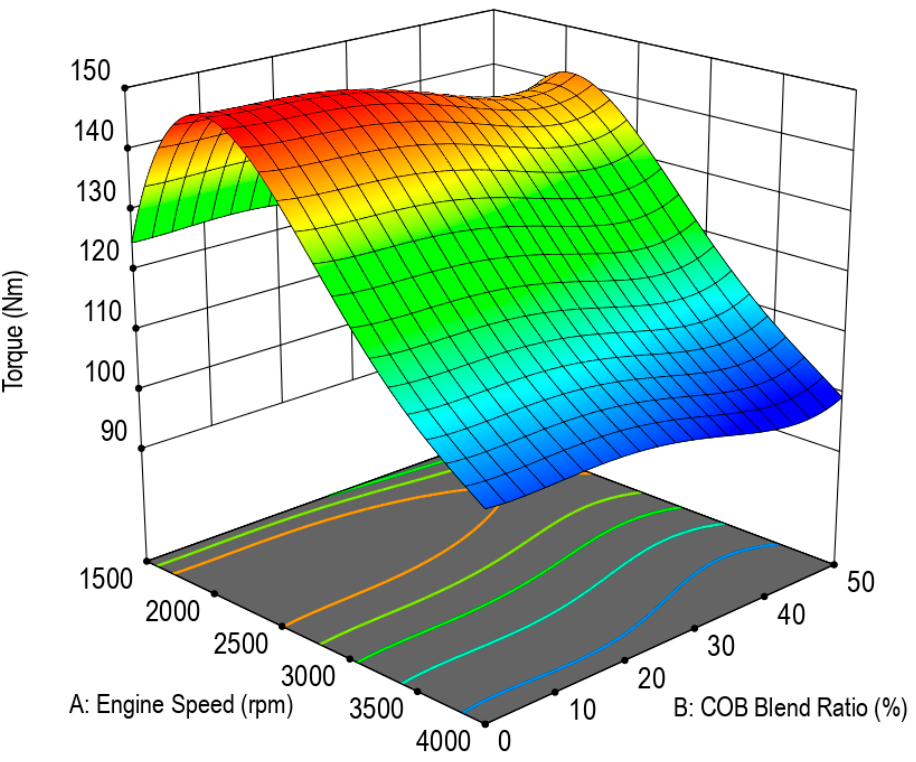
Figure 4. Engine torque at various engine speeds for all test fuels. Processes 2020 , 8 , x FOR PEER REVIEW